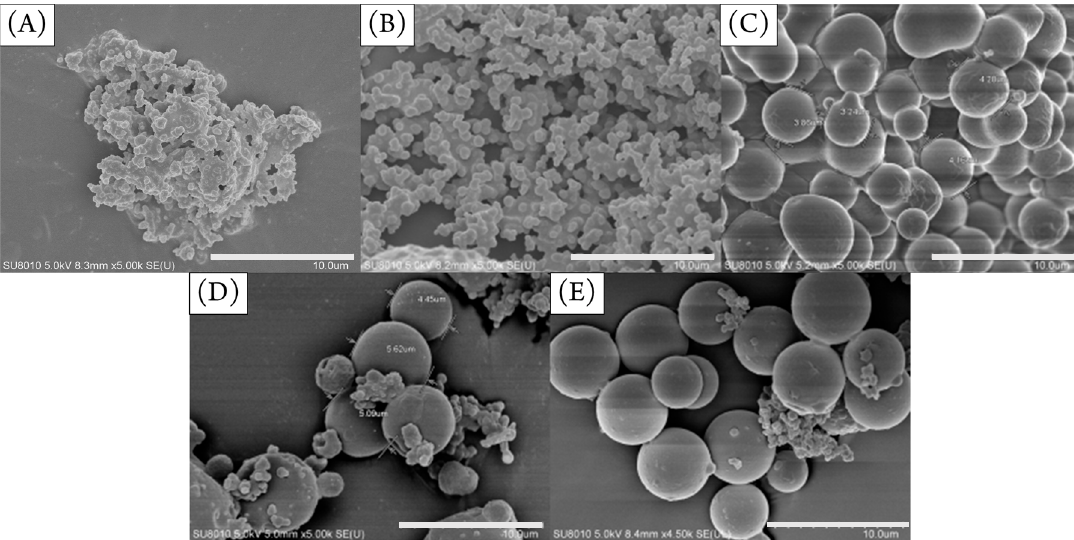
Figure 4. SEM images of microcapsules prepared with different addition amounts of sodium chloride. 0 ( A ), 1 wt% ( B ), 2 wt % ( C ), 4 wt% ( D ), and 8 wt% ( E ). The scale bars are all 10 μ m.